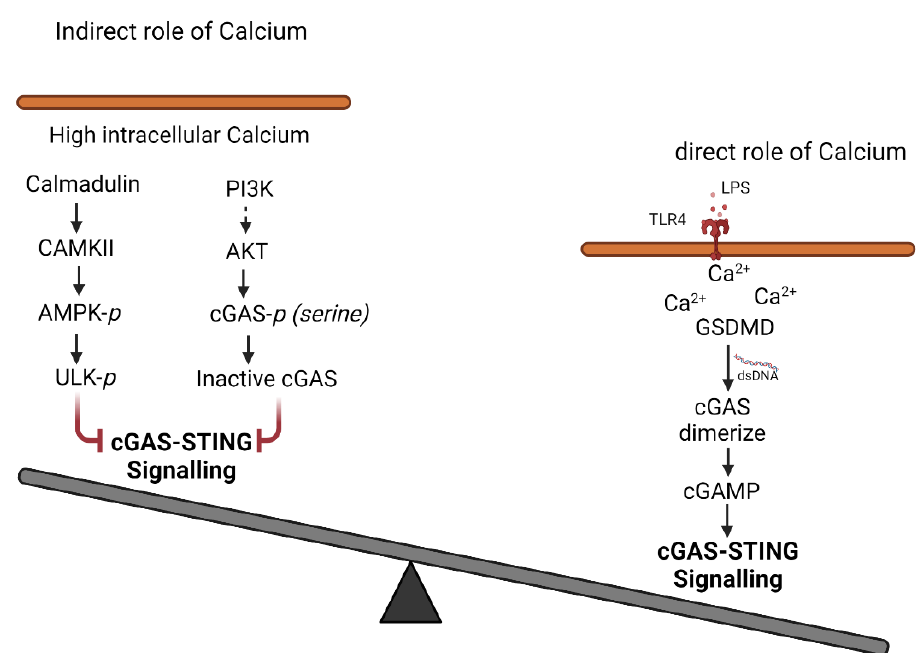
Figure 4. Indirect role of calcium . Calcium/calmodulin-dependent protein kinase II (CAMKII) may alter cGAS activation of STING. CAMKII induces phosphorylation of AMP-activated protein kinase (AMPK). Phosphorylation of AMPK induces STING signaling through repressing ULK1 by its phosphorylation. ULK1 phosphorylates and negatively regulates cGAS-STING signaling. Indirect activation of AKT via PI3K can also suppress cGAS activity through AKT phosphorylation of cGAS at serine residue (s305/s291). Direct role of calcium . LPS induces TLR4 signaling resulting in an increase in intracellular Ca 2+ . LPS also induce GSDMD cleavage, which in turn induces pore formation in the mitochondria releasing mitochondrial DNA (Mt DNA) in the cytosol. Mt DNA activates cGAS dimerization. This results in the generation of secondary messenger cGAMP and thus activation of cGAS-STING